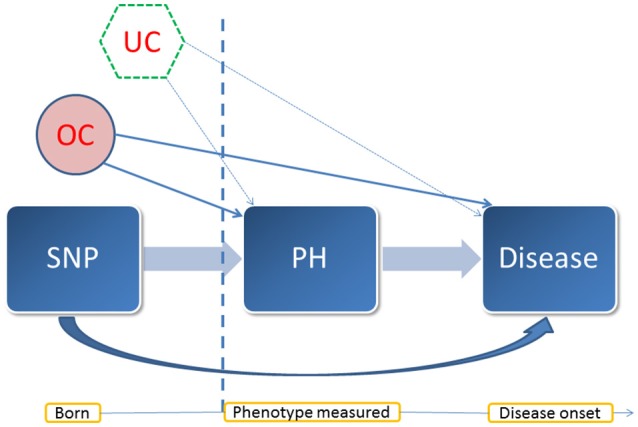
A diagram of the mediation analysis. This diagram illustrates the assumed causal relationship between the entities involved in the mediation analysis and their temporal pattern. PH: a quantitative trait treated as a mediator. In this case, it was an endophenotype of interest. OC: observed confounders such as sex and age. UC: potential unmeasured confounders. In the mediation analysis, we assumed that there was no unmeasured confounder behind the baseline measurement of the mediator and the onset of the disease under investigation. Vertical dash line: the time point at the measurement of the mediator.